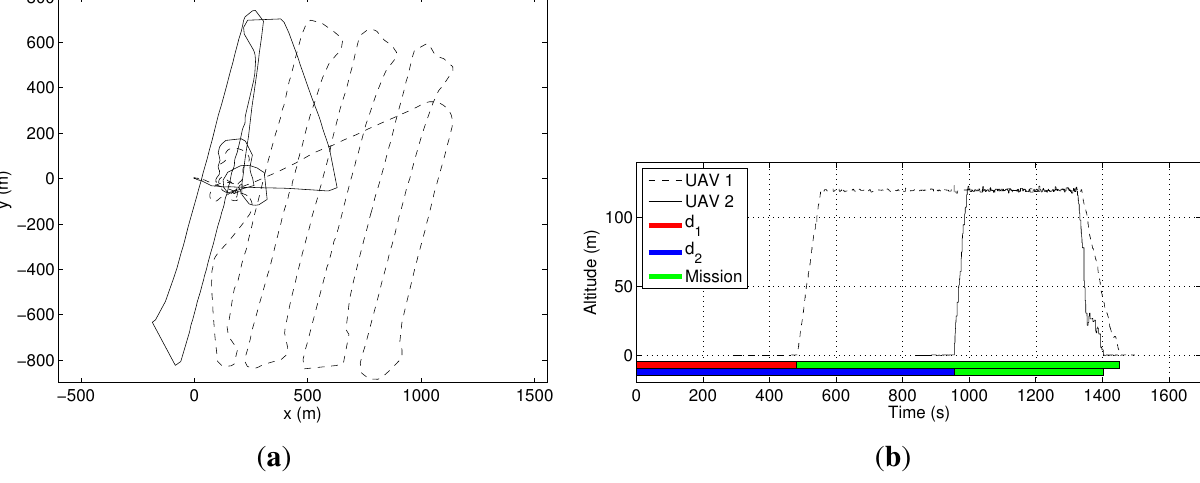
Figure 14. Coverage of the area in Figure 12 with two UAVs. ( a ) The UAVs’ paths projected on a cartographic reference system; ( b ) the UAVs’ altitude. In this figure, d cumulative setup times of UAVs 1 and 2 ,